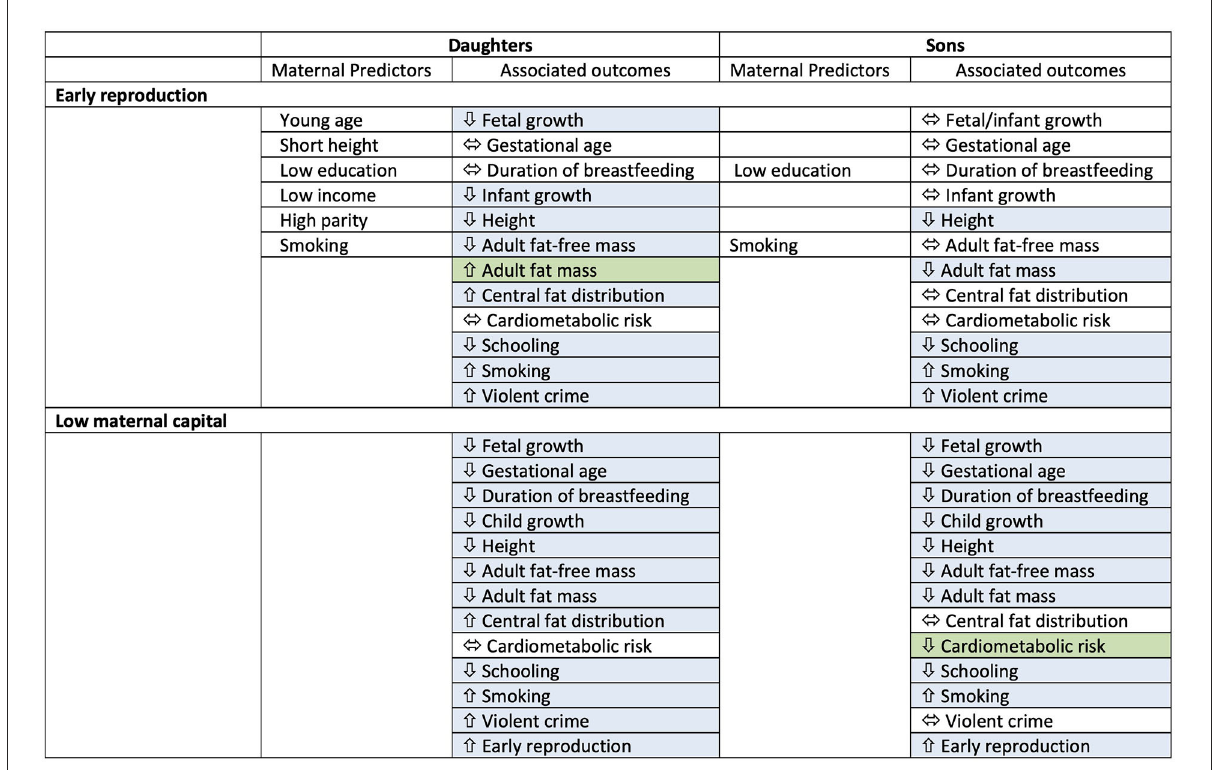
FIGURE7 Summary table for results of associations of early reproduction and exposure to low maternal capital with outcomes in both sons and daughters. Maternal predictors of early reproduction are also indicated. Blue cells indicate an association, green cells indicate where one sex shows the opposite direction of effect compared to the other sex. Overall, sons show fewer associations of physical traits with early reproduction, and in contrast to daughters, low maternal capital is associated with lower cardiometabolic risk in